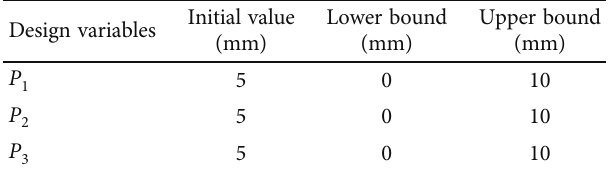
Table 2: Value range of design